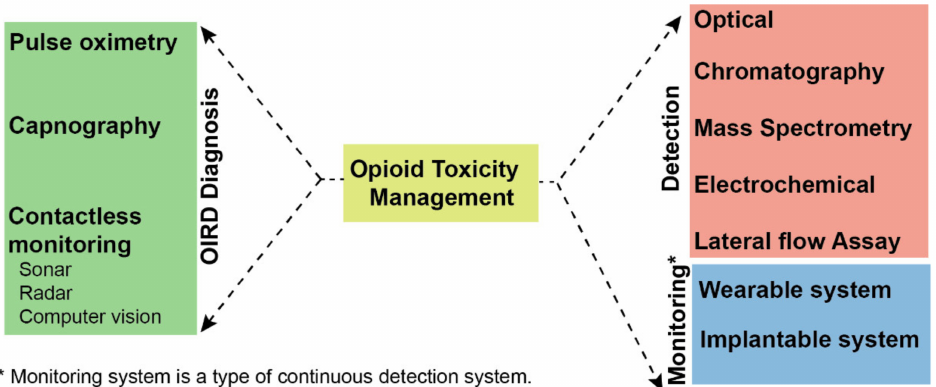
Figure 1. Overview of techniques for management and detection of opioid